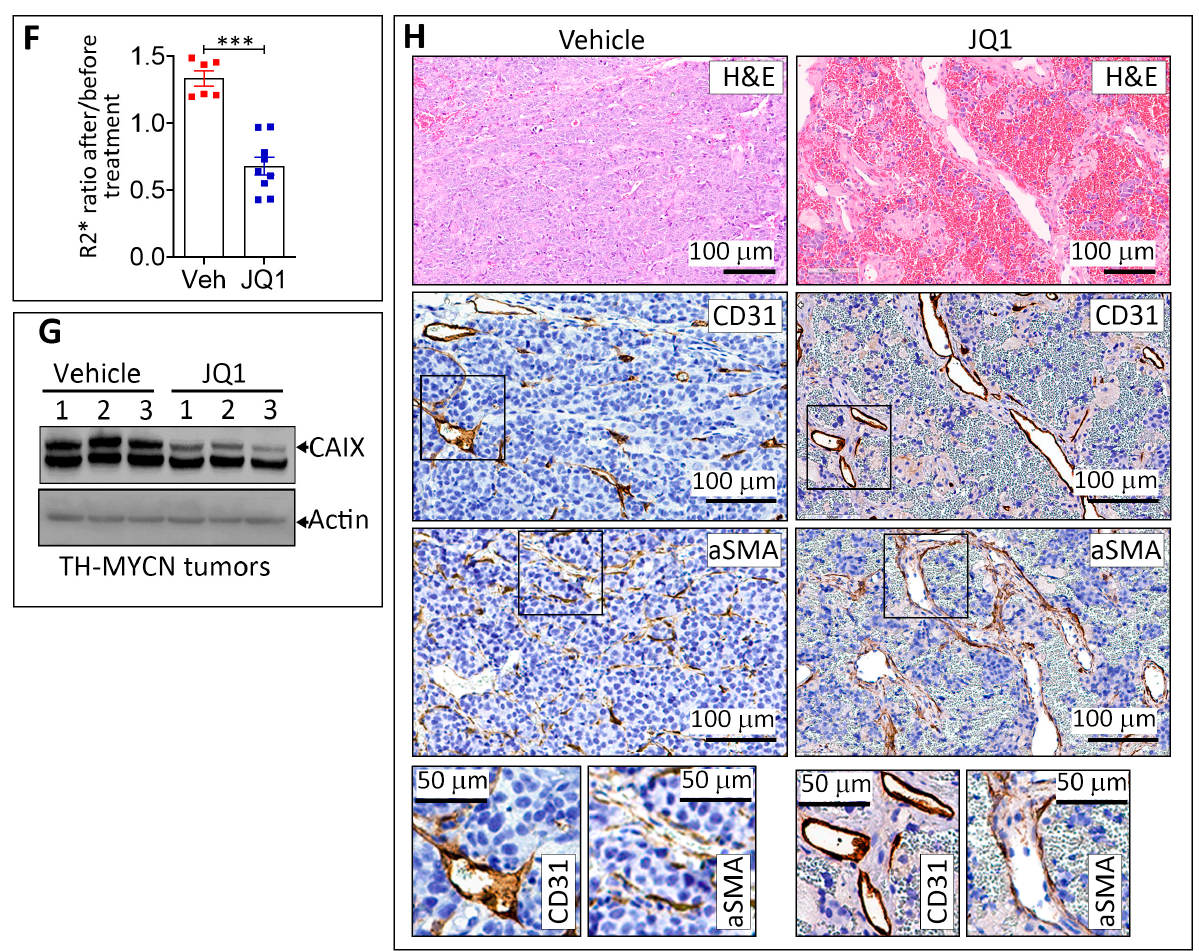
Figure 2. Effect of JQ1 on the hypoxia status and blood vessels in TH-MYCN tumor-bearing mice. ( A ) Experimental design of JQ1 treatment of TH-MYCN tumor-bearing mice showing the schedule and dosing. Following the development of homozygote TH-MYCN tumors, the tumor volume and R2* values were assessed by an MRI in all mice. Mice were randomly assigned to a vehicle-treated group ( n = 6) or JQ1-treated group ( n = 9). Mice were treated twice with either the vehicle or JQ1 (50 mg/kg) by IP on days 1 and 2. On day 3 post-treatment, an MRI was performed to determine the tumor volume and R2* values. Tumors were harvested for subsequent experiments. ( B ) The volume of TH-MYCN tumors treated with either the vehicle (Veh) or JQ1 as described in ( A ) on day 3. Each dot represents one tumor. Results are shown as mean ± SEM (error bars). Statistically significant differences were calculated compared to the Veh-treated tumors using an unpaired two- tailed Student’s t -test (ns: not significant). R2* values in TH-MYCN tumors before and after treatment on day 3 with the vehicle ( C ) and JQ1 ( D ) according to the experimental design in ( A ). The R2* values in TH-MYCN tumors after the treatment with either the vehicle (Veh) or JQ1 are reported in ( E ). The R2* ratio of after to before treatment with the vehicle (Veh) or JQ1 is reported in ( F ). Each dot represents one tumor. Results are shown as mean ± SEM (error bars). Statistically significant differences are calculated using a Mann–Whitney test for ( C ) and ( D ) or an unpaired two-tailed Student’s t -test for ( E ) and ( F ) (* p < 0.05, ** p < 0.01; and *** p < 0.001; ns: non-significant). ( G ) Western- blot showing the protein expression of CAIX in three different (1, 2 and 3) TH-MYCN tumors treated with either the vehicle or JQ1 according to the experimental schedule described in ( A ). Actin was used as a loading control. ( H ) Staining of vehicle- or JQ1-treated TH-MYCN tumors described in ( A ) with H&E (upper panels), CD31 (middle panels), or aSMA lower panels. Enlarged images of the zones delineated with black boxes (in CD31 and aSMA stained tumors) are shown (Scale bars 100 or 50 µ